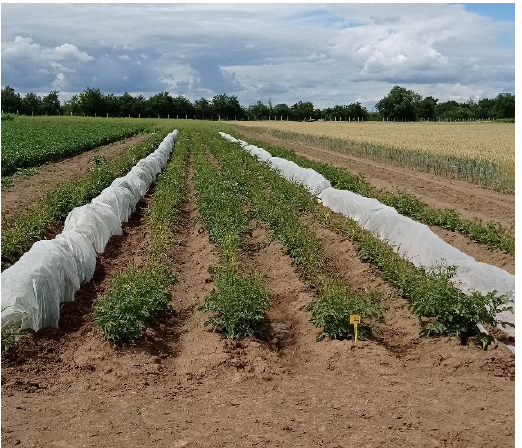
Figure 1. Experimental field with experimental rows covered with non-woven fabric.